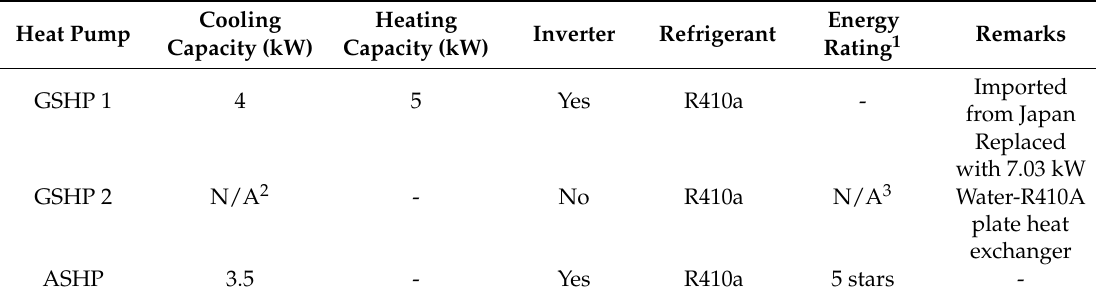
Table 1. Technical specifications of the heat pumps used in the present study.